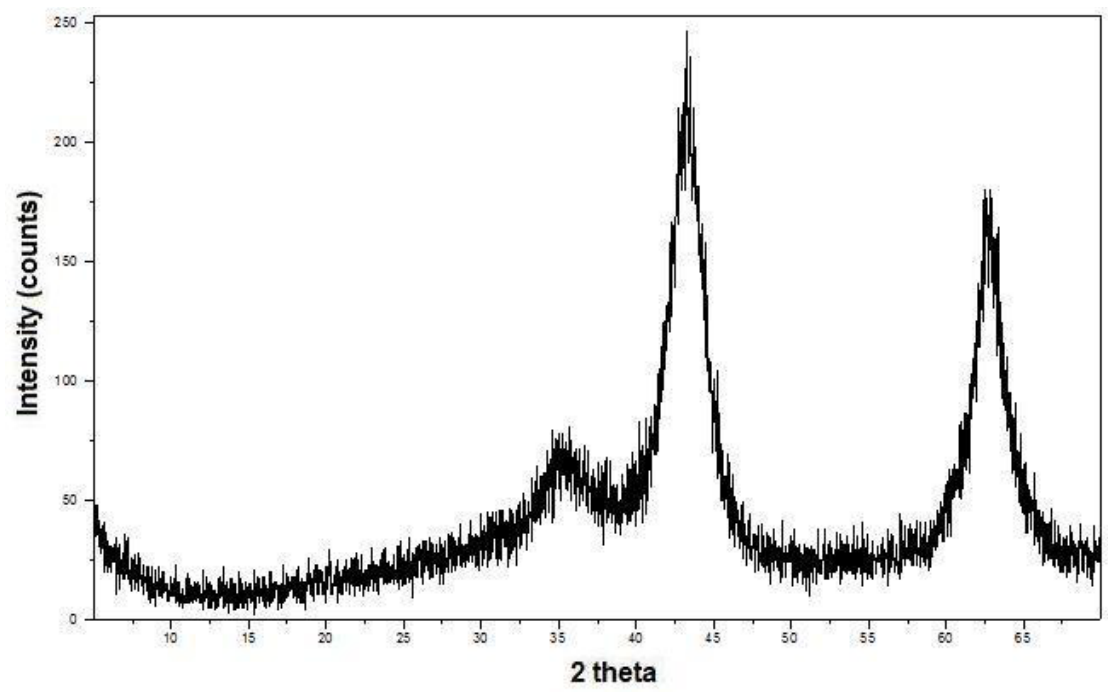
Figure 5. Diffractogram of HTc.